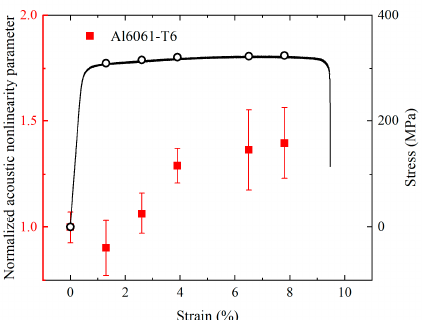
Figure 11. Relationship of acoustic nonlinearity parameters A − strain, superimposed on stress-strain curve of 6061-T6 aluminum alloy with maximum engineering strains for six samples marked.